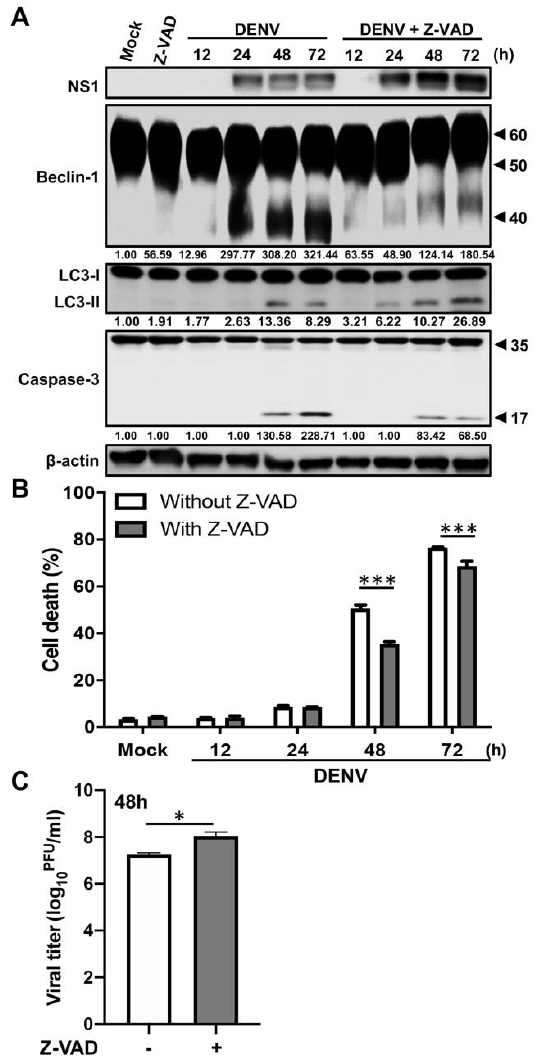
Figure 3. Caspases mediate cleavage of Beclin-1 in the DENV-infected cells. A549 cells were pretreated with or without 25 µ M Z-VAD and then infected with DENV at MOI = 2 for the indicated time. ( A ) Western blot analysis showing representative images of NS1 levels, Beclin-1 levels (full-length: 60 kDa, cleaved form: around 50 and 40 kDa), LC3-II accumulation, as well as procaspase-3 (35 kDa) and cleaved caspase-3 (17 kDa) levels in A549 cells. β -actin is shown for loading control. The blots were quantified by using β-actin as a calibrated control. The relative ratios (numbers below the blots) of LC3-II, cleaved Beclin-1 (40 kDa) or cleaved caspase-3 to the mock were indicated. ( B ) The